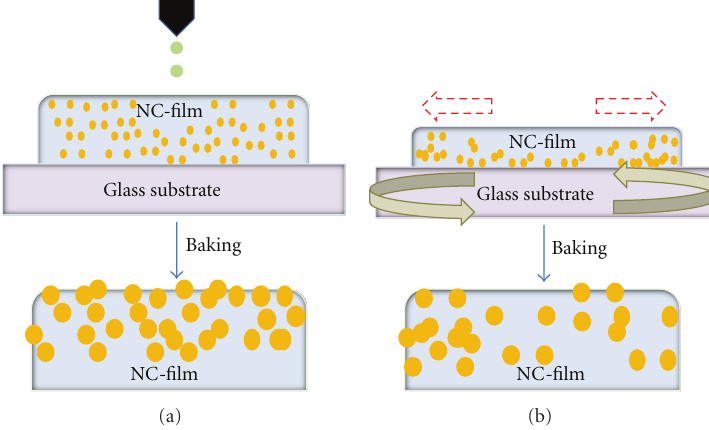
between IJP and SPC methods are shown in Figure